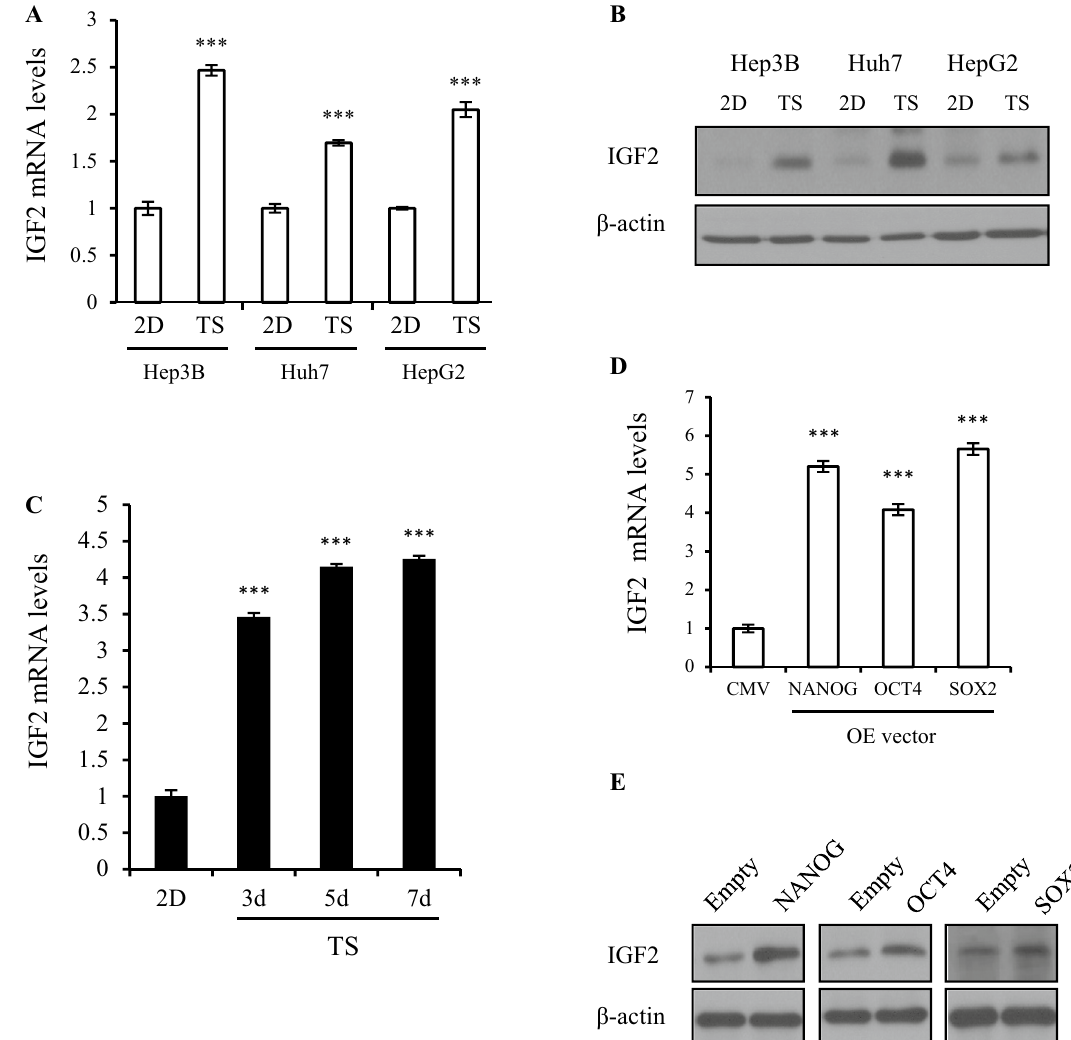
Figure 3. IGF2 is regulated by stemness factor. ( A ) IGF2 expression was detected by an mRNA array between tumorsphere (TS) and adherent (2D) cells. In the three liver cancer cell lines (Hep3B, HuH7, and HepG2), IGF2 mRNA ( A ) and protein ( B ) levels were measured with qRT-PCR and an immunoblot assay. Blots were cropped to show specific bands. ( C ) IGF2 expression was examined during sphere culture (3, 5, 7 days). (D-E) IGF2 mRNA ( D ) and protein ( E ) expression was detected after transient transfection of stemness factor (NANOG, OCT4, and SOX2). For qRT-PCR, relative expression was calculated using 18 s expression as an internal control. Immunoblots used β-actin as a loading control. Blotted proteins were visualized by enhanced chemiluminescence (GE Healthcare, UK) with the automatic X ray film Imaging System (Konica Minolta, Japan). Blots were cropped to show specific bands. The average (column) ± SD (bar) is indicated ( *** p <